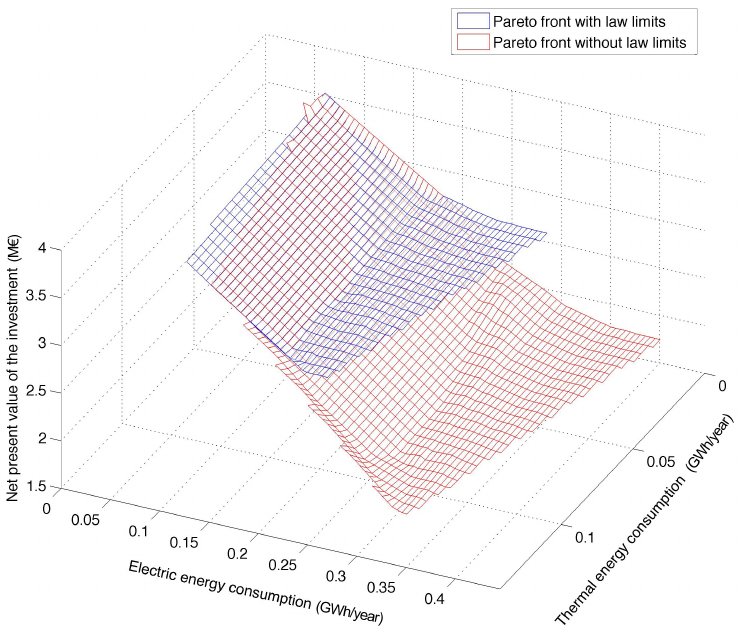
Figure 4. Effects of legal limits on the generation of the Pareto front for the case study building with an increase of the